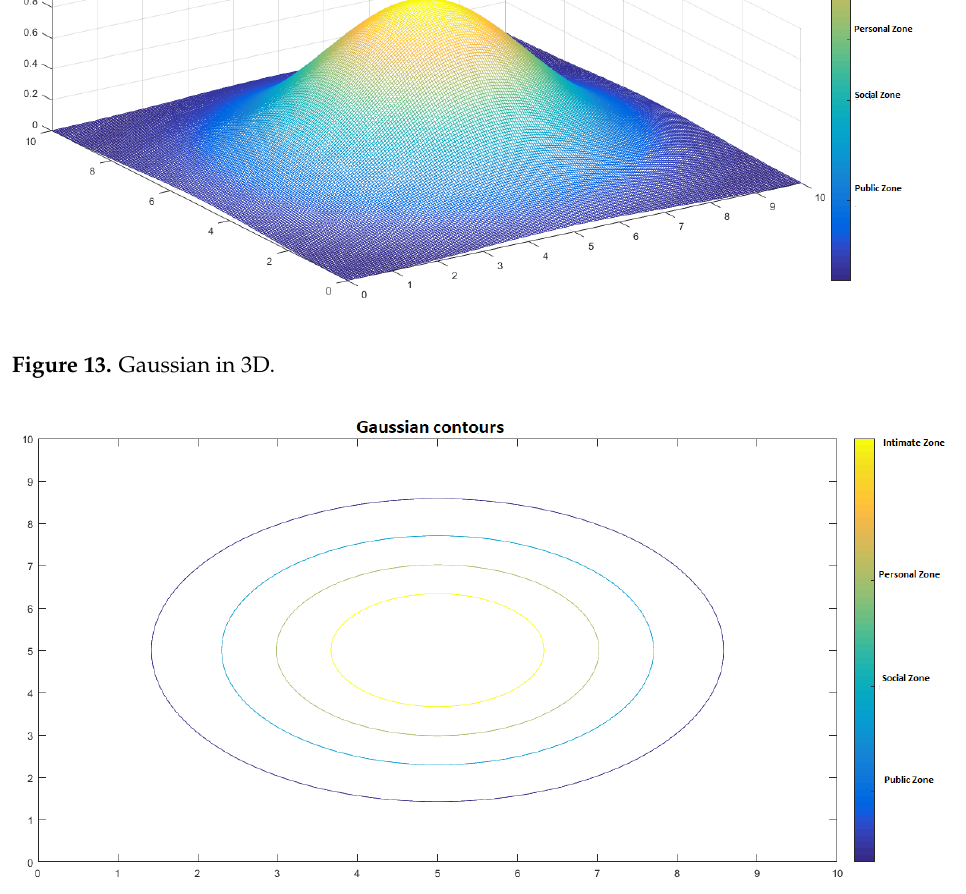
Figure 14. Representation of proxemic zones by a symmetrical